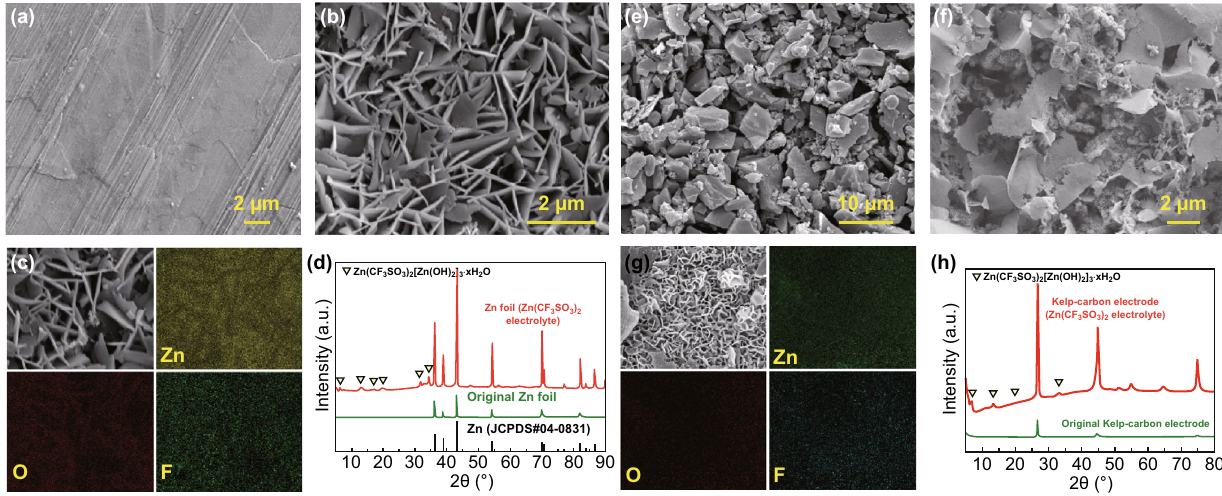
Fig. 4 SEM images on the surface of Zn foil anode: a original and b after 4,000 cycles. c Corresponding EDS mapping on the surface of Zn foil anode after 4,000 cycles. d XRD patterns of the anode before and after 4,000 cycles. SEM images on the surfaces of kelp-carbon cathode: e original and f after 4,000 cycles. g Corresponding EDS mapping on the surface of kelp-carbon cathode after 4,000 cycles. h XRD patterns of the cathode before and after 4,000